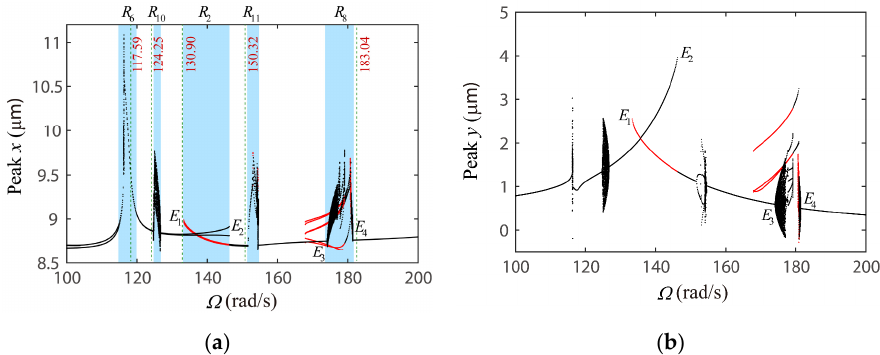
Figure 21. For δ 0 = 4.0 μ m, numerical bifurcation diagrams of local maxima ( a ) x ( τ ) and ( b ) y ( τ ) when Ω sweeps up (black dots) and down (red dots) around 100-200 rad/s.